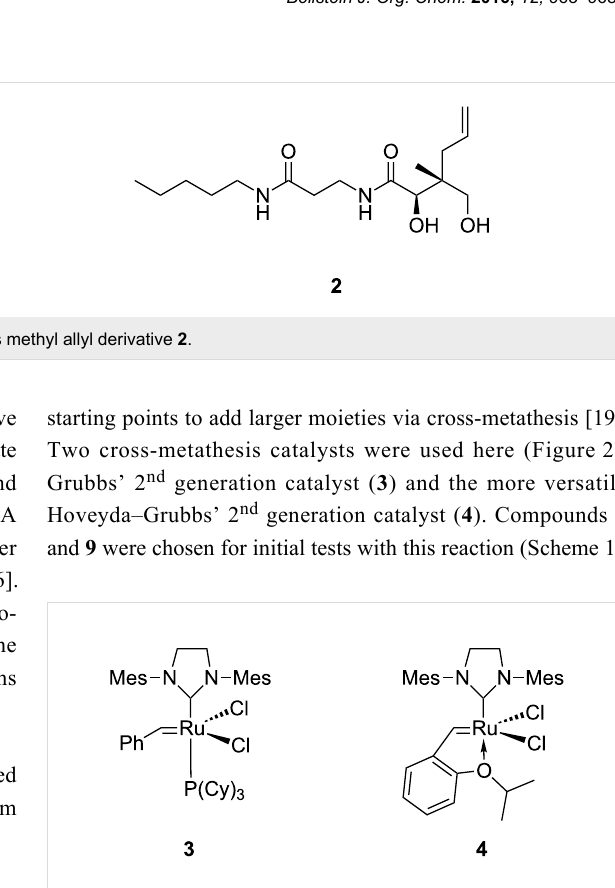
Figure 2: Structure of Grubbs’ catalysts used in this